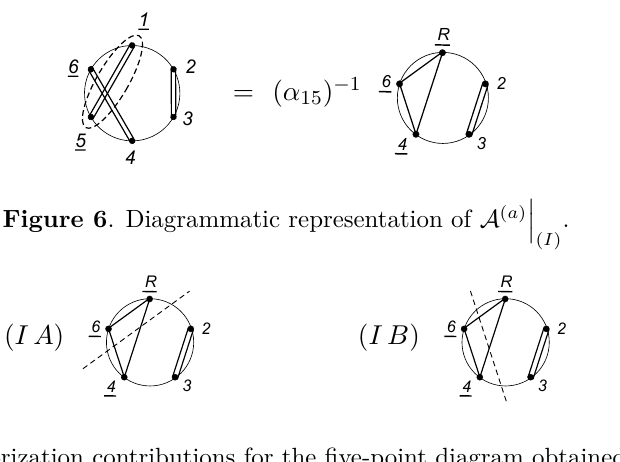
Figure 7 . Factorization contributions for the five-point diagram obtained in A ( a )